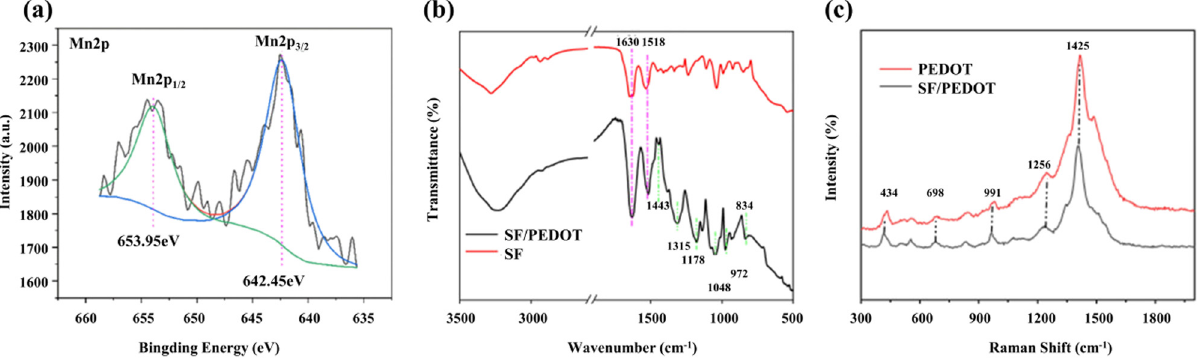
Figure 4: ( a ) The XPS high resolution Mn2p spectrum of oxidized SF fi lm. ( b ) FTIR spectra of SF and SF/PEDOT membrane. ( c ) Raman spectra of pure PEDOT reacted for 8 h and SF/PEDOT membrane reacted for 8